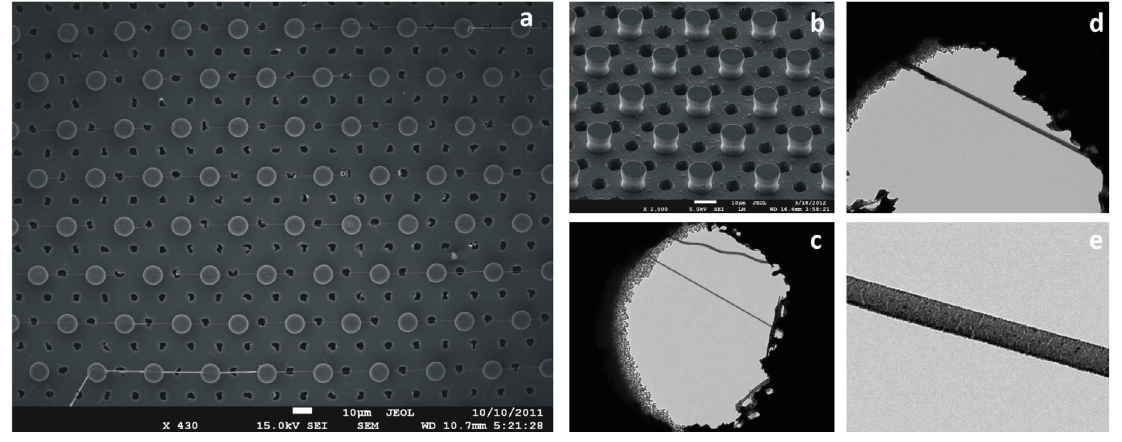
Figure 10. Super hydrophobic surfaces ( a , b ) with very low adhesion forces allow one to avoid the pinning of the drop during evaporation. As a result, DNA molecules are deposited, suspended and well tensed between the pillars ( a ), and more importantly, several DNA bundles resulted in being suspended in correspondence with the holes ( c – e